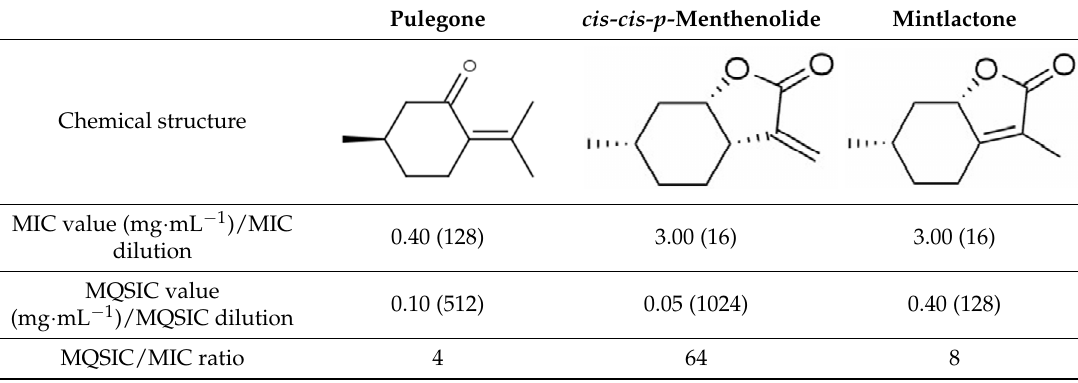
Table 2. Antimicrobial and anti-QS assays of pulegone, cis-cis-p-menthenolide and mintlactone. Pulegone cis-cis-p- Menthenolide